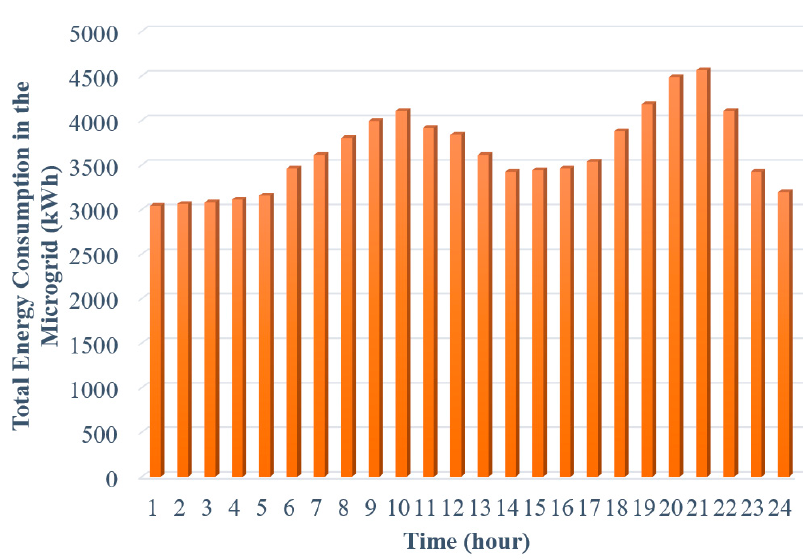
Figure 7. Total energy consumption value in the microgrid in the base case (ignoring HEVs’ de- mand and DGs).